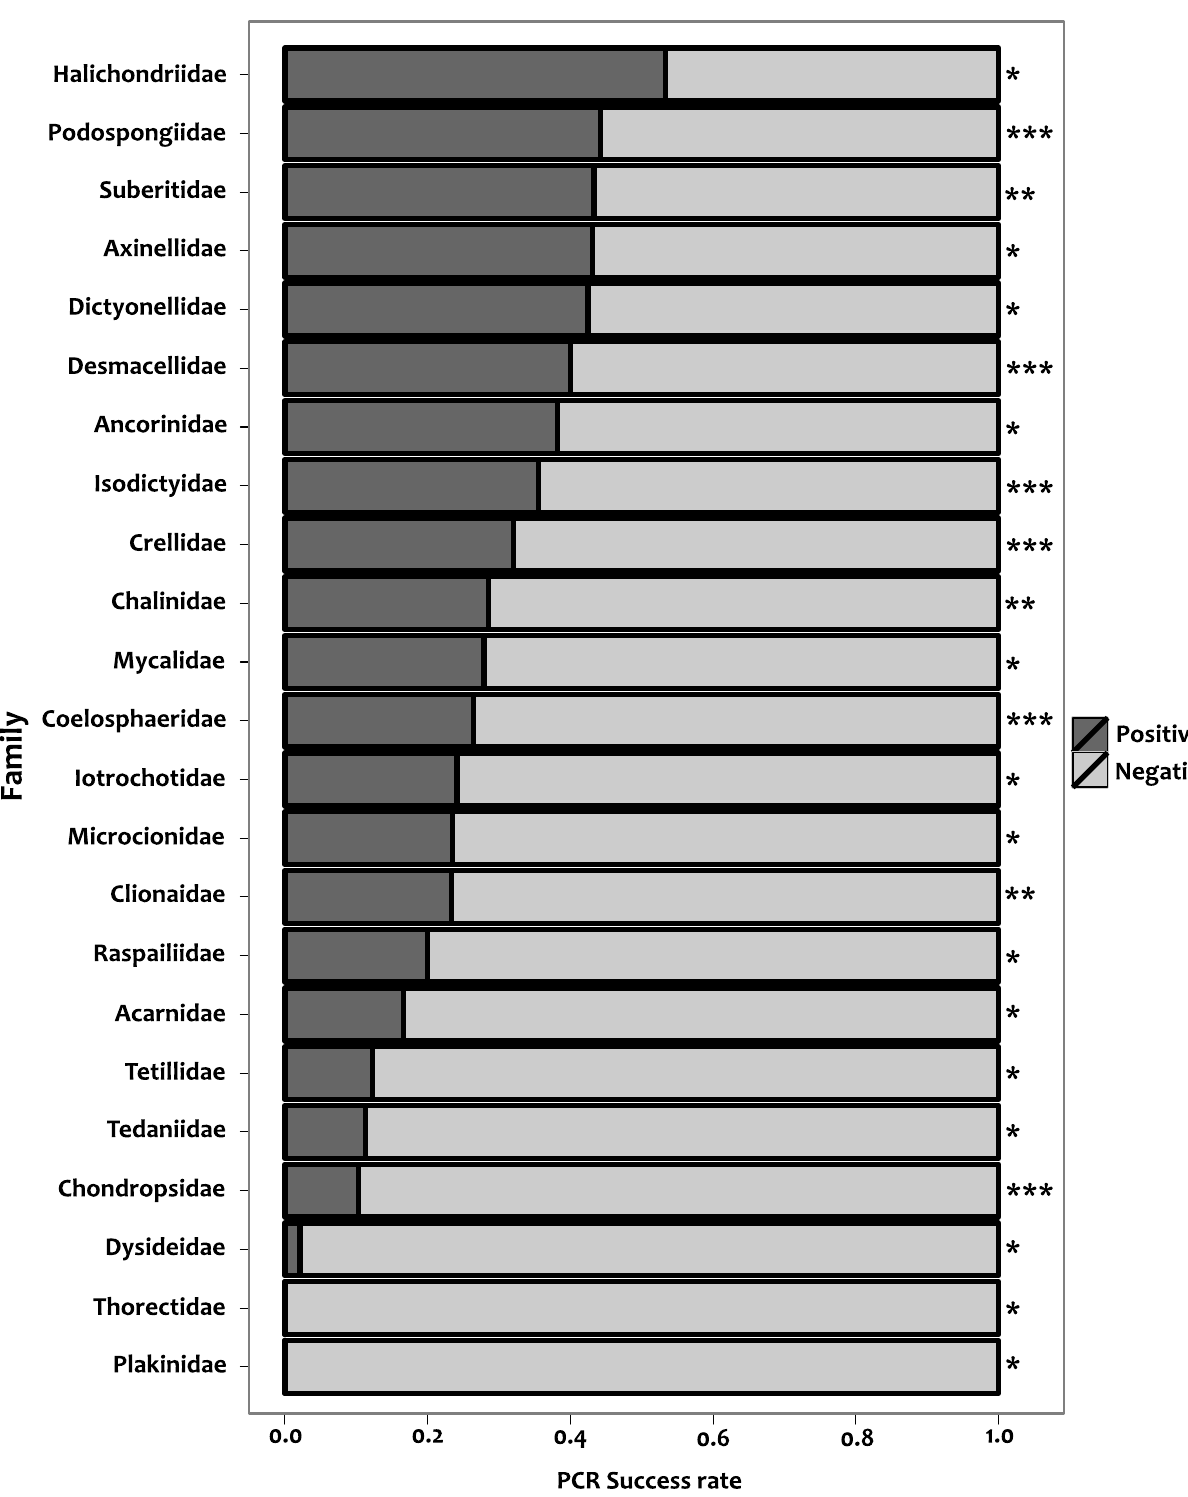
Figure 1. Amplification success of the standard barcoding COI partition per sponge family. Grey and black colours represent failed and positive reactions, respectively. Only families with more than 30 documented PCRs are included in the figure, these taxa correspond to the families analised in the generalised linear model. Asterisks on the right side correspond to the different family groups analysed: *: Acarnidae, Ancorinidae, Axinellidae, Dictyonellidae, Dysideidae, Halichondridae, Iotrochotidae, Microcionidae, Mycalidae, Plakinidae, Raspailidae, Tedaniidae, Tetillidae and Thorectidae; **: Chalinidae, Clionaidae and Suberitidae; ***: Chondropsidae, Coelosphaeridae, Crellidae, Desmacellidae, Isodictyidae and Podospongiidae.